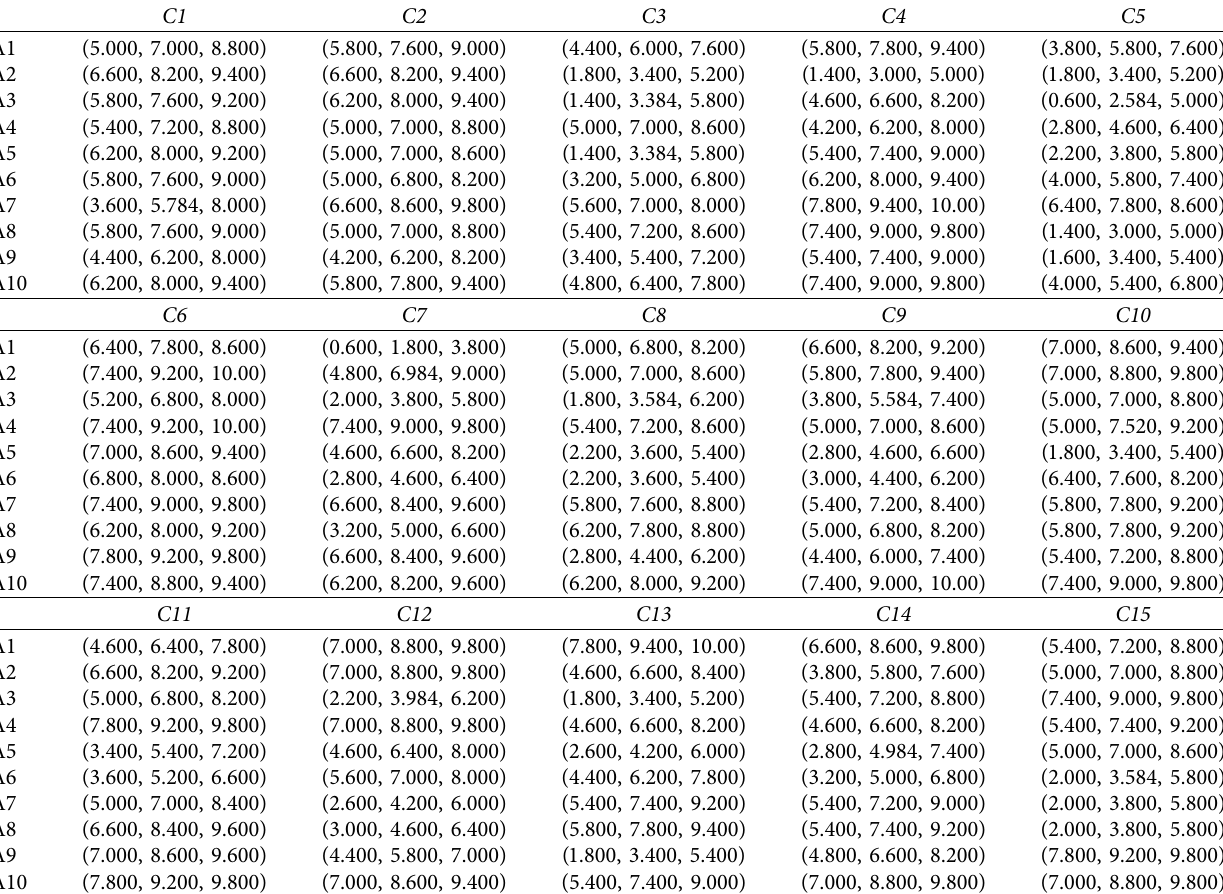
Table 8: Fuzzy evaluation matrix ( 􏽥 Z